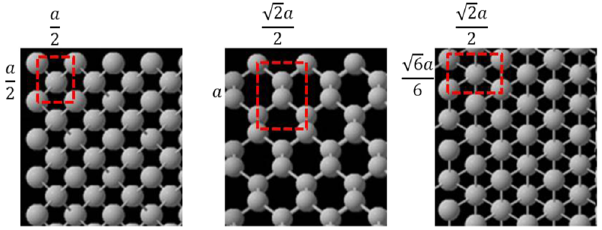
FIG. 2. Schematic representations of the GaAs crystal for three surface cleave planes, looking normal to the surface — from left to right, (100), (110) and (111A). The red boxes denote the recurring geometric cells used for calculating the atomic number density for each cleave plane and a is the GaAs lattice constant.